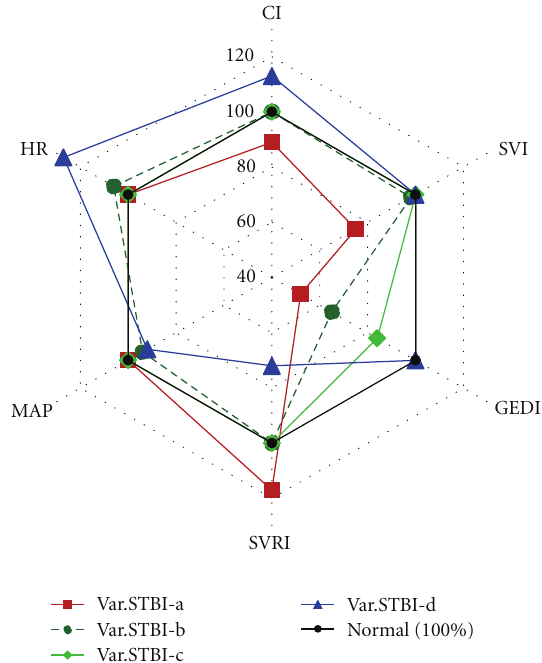
Figure 1: Variants of hemodynamic reaction in the patients of group STBI on the first day. Note. Hemodynamic parameters are presented with percents from the normal